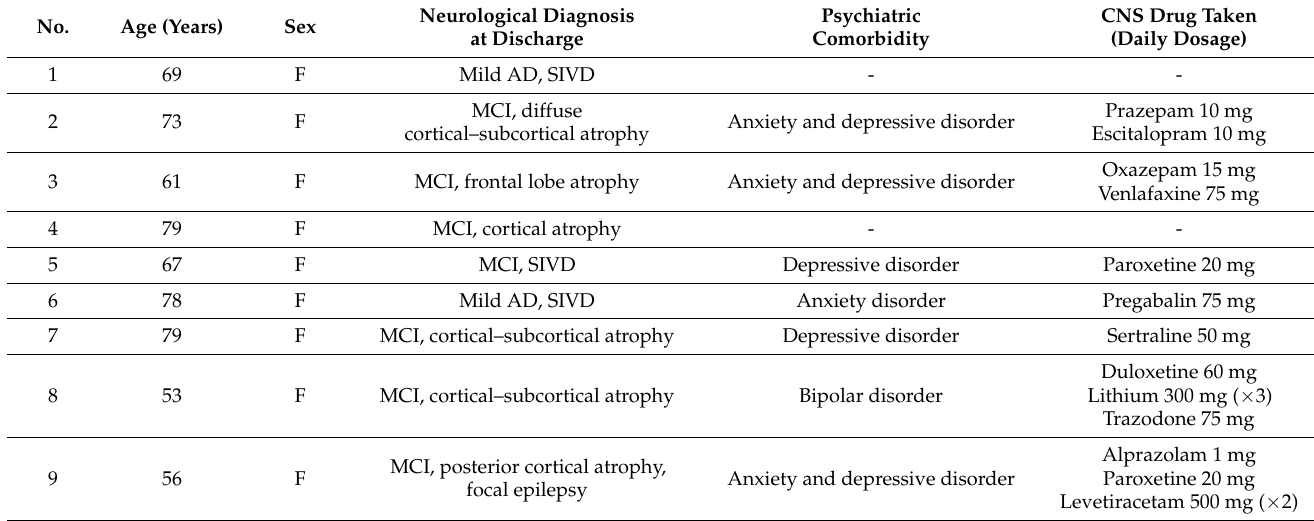
Figure 1. Examples of prurigo nodularis typically observed in two patients included in this report. Table 1. Main characteristics of the patients with prurigo nodularis included in this